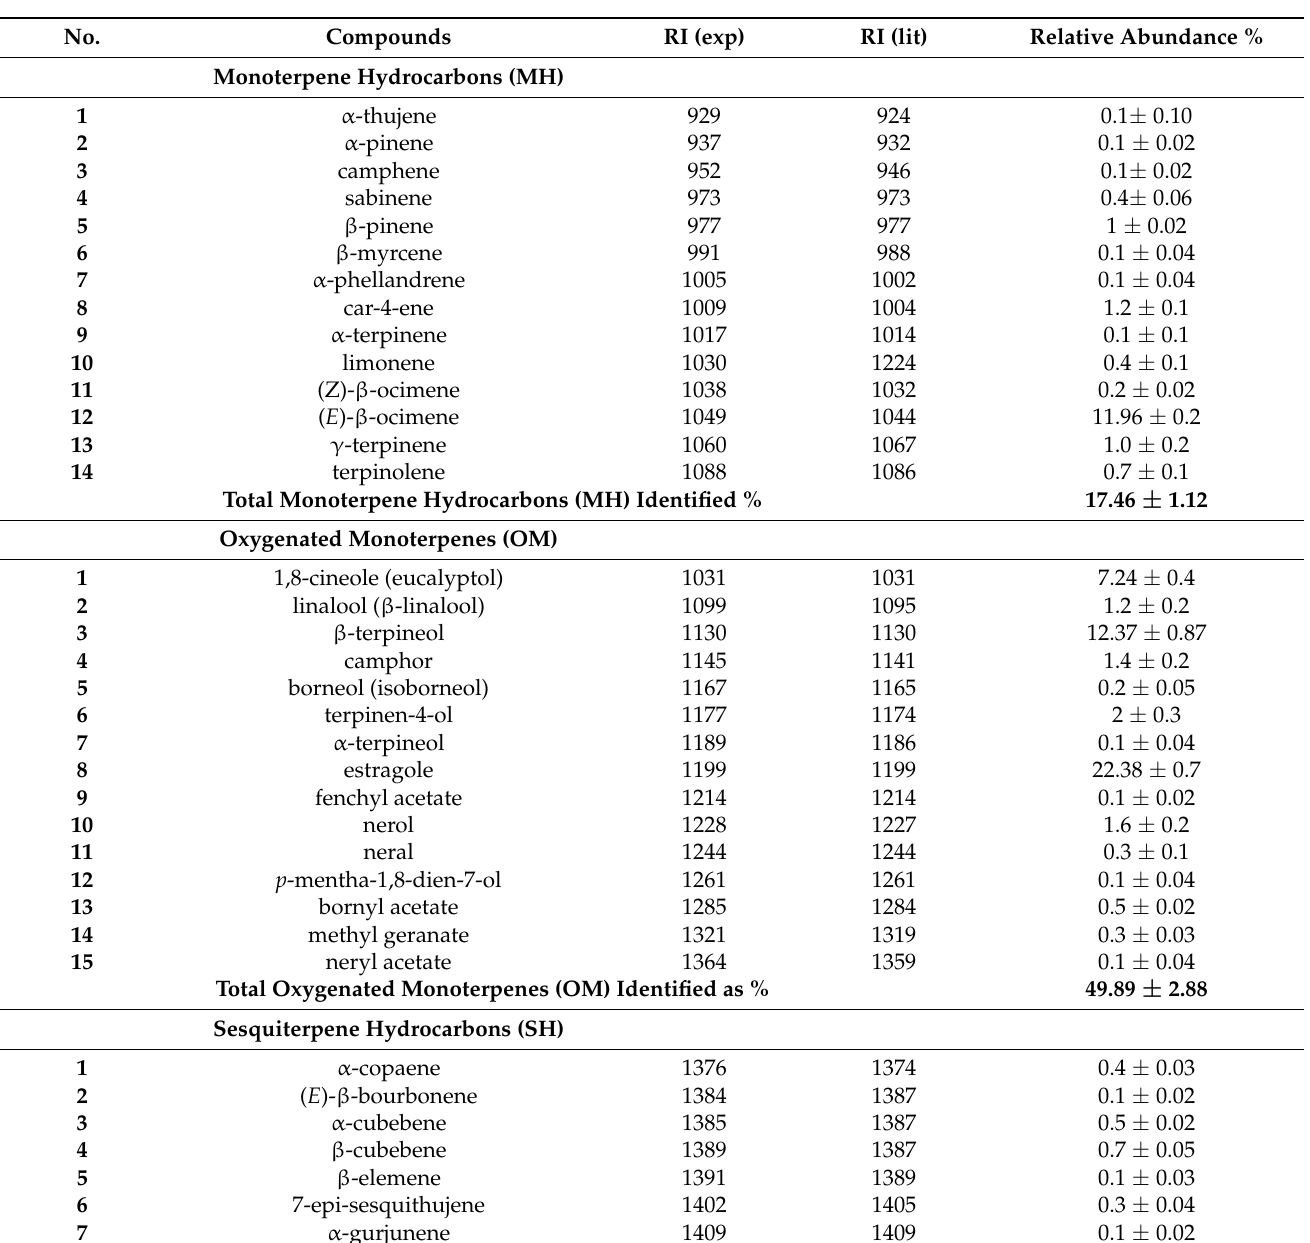
Table 1. O. basilicum ’s cell suspension extract’s chemical components classes and the overall identified extract, including oxygenated sesquiterpenes (OS), oxygenated monoterpenes (OM),